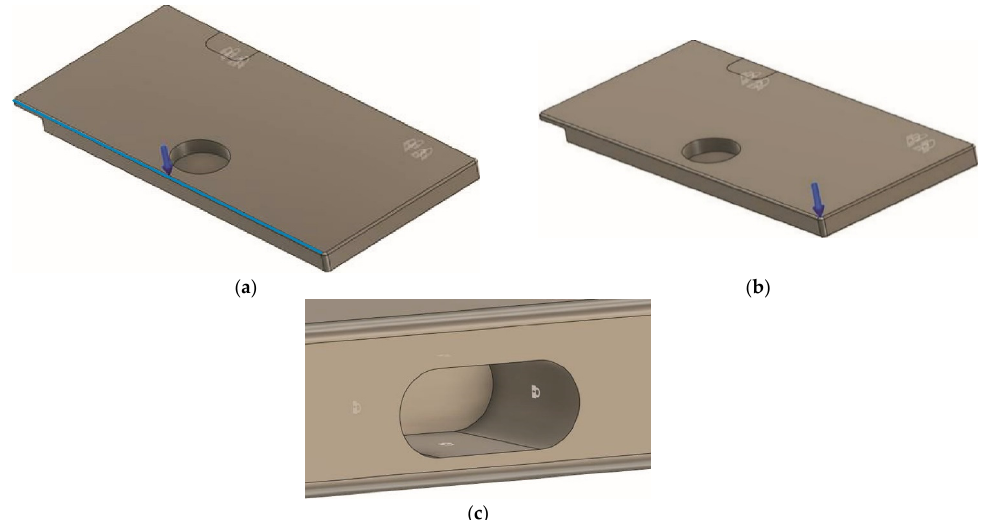
Figure 2. Load case 1 ( a ), 2 ( b ), and boundary conditions for the seat folding table ( c ).